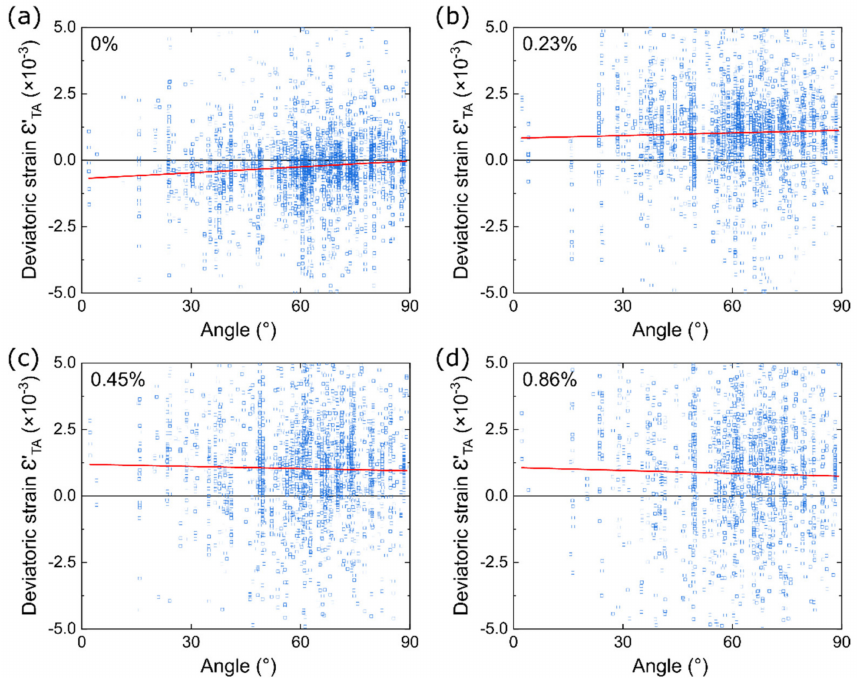
Figure 11. The dependence of the deviatoric strain ε (cid:48) TA on the misalignment angle between the tensile axis and the c-axis of Ti grains in the top Ti layer. ( a ) Before tensile loading; ( b ) after a strain of 0.23%; ( c ) 0.45%; ( d ) 0.83%. The red lines show linear fittings.